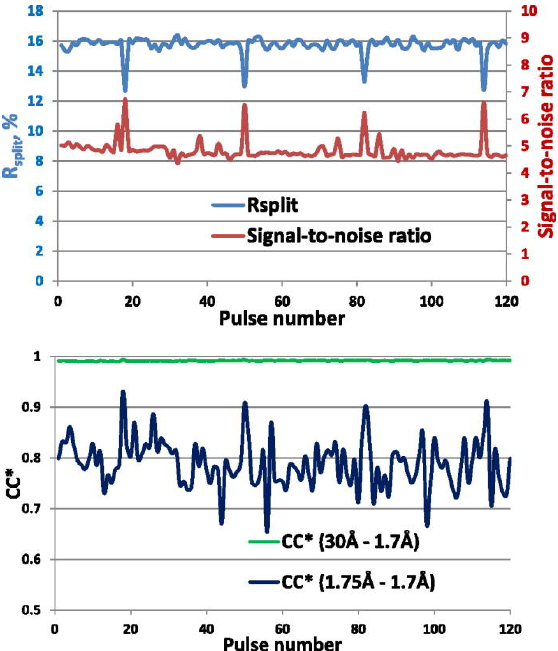
Figure 8. Data quality metrics, as determined from each pulse number, show that the structural data are independent of pulse number and that there is no systematic change in data quality across the train. Any section of the train can be utilized for data collection without compromise. Notably, the repetitive dips in data quality were due to known detector behavior and not due to the experiment itself. Figure originally published in Struct. Dyn. [52]; licensed under a Creative Commons Attribution (CC BY)